Question: Reading the figure, is the described quantity rising or falling?
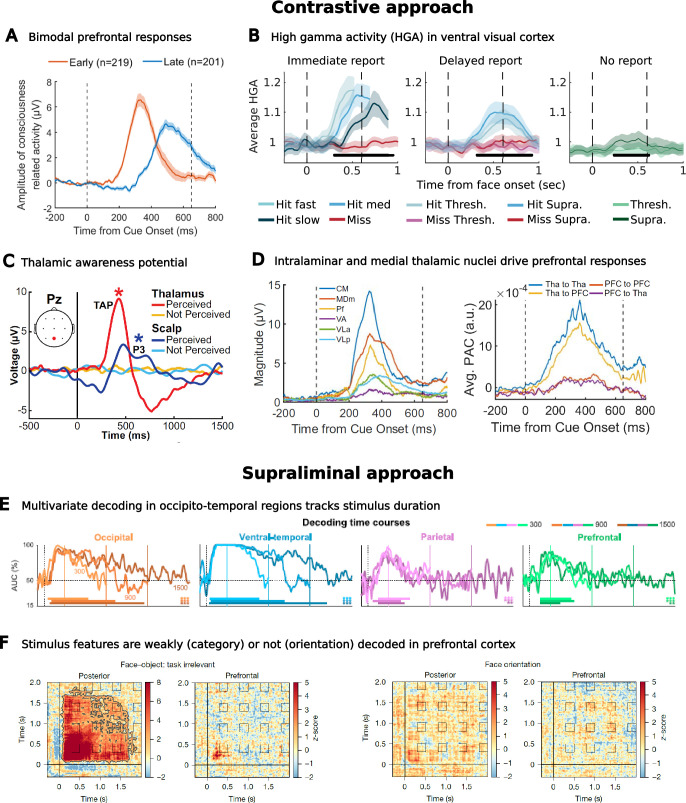
Answer: increasing